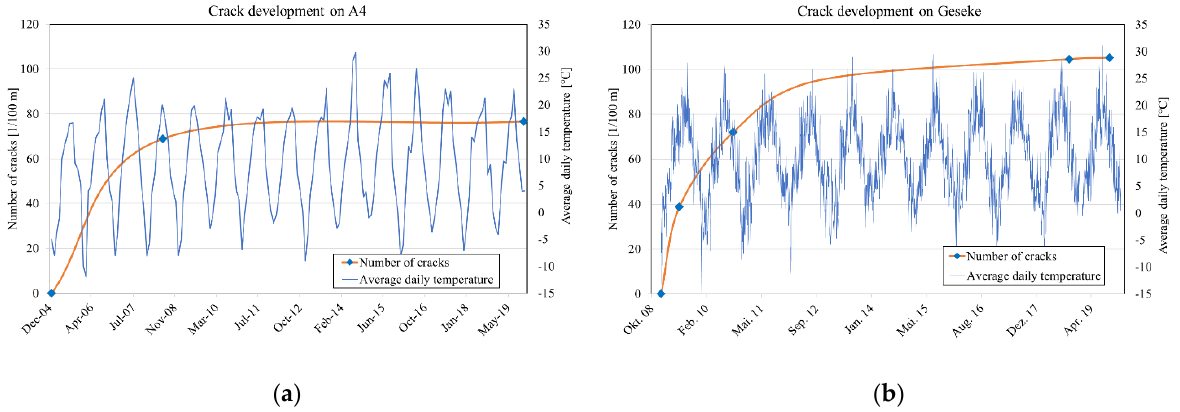
Figure 4. Development of the crack pattern from placement to 2019: ( a ) A4 (PL), ( b ) Geseke (DE).